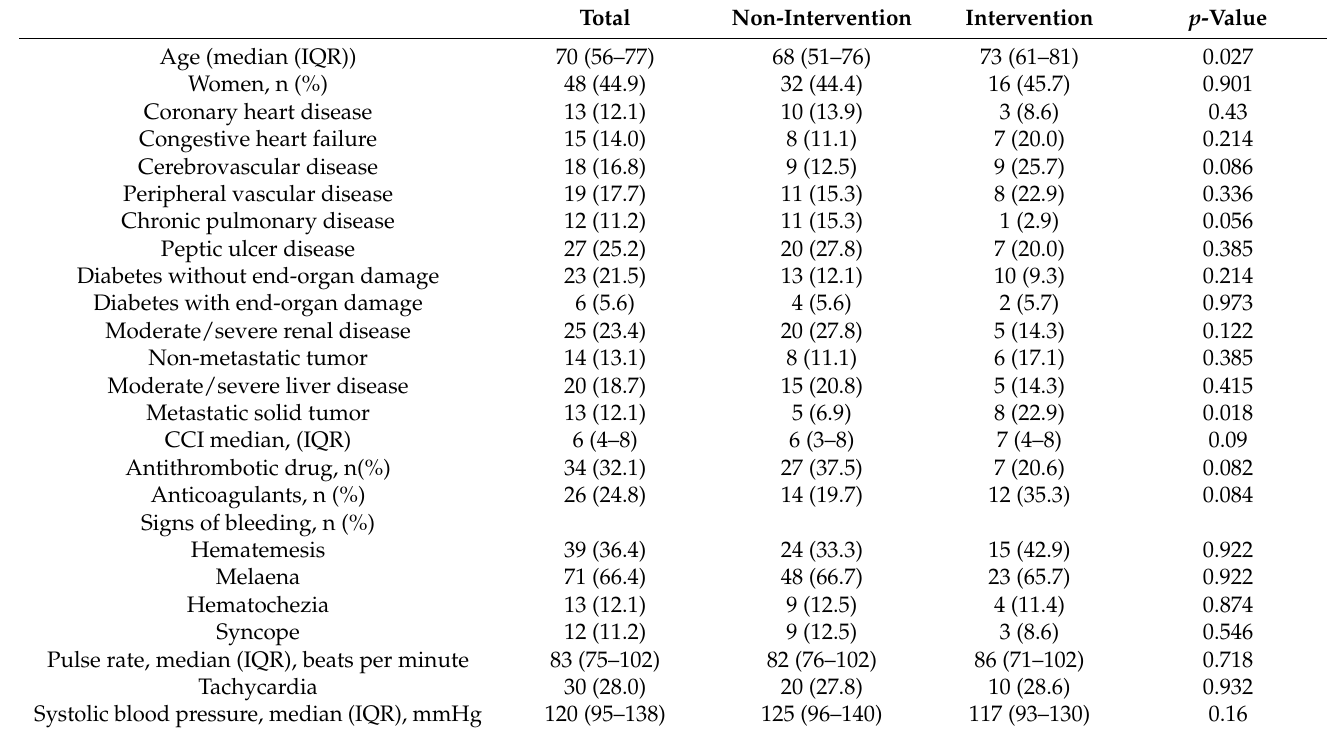
Table 1. Patient baseline